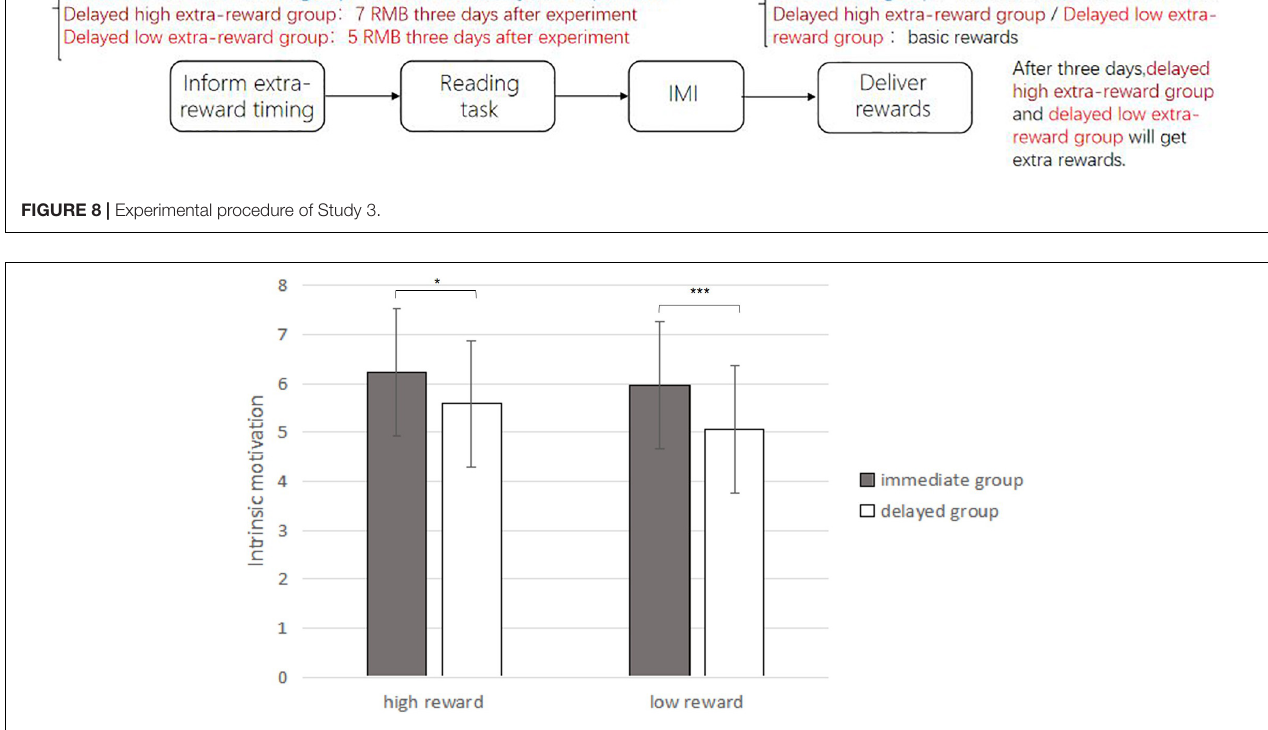
FIGURE 9 | Influence of extra reward timing and extra reward magnitude on intrinsic motivation (In the bar graph above, the error bars represent the standard deviations; ∗ represents p < 0.05, ∗∗∗ represents p < 0.001).